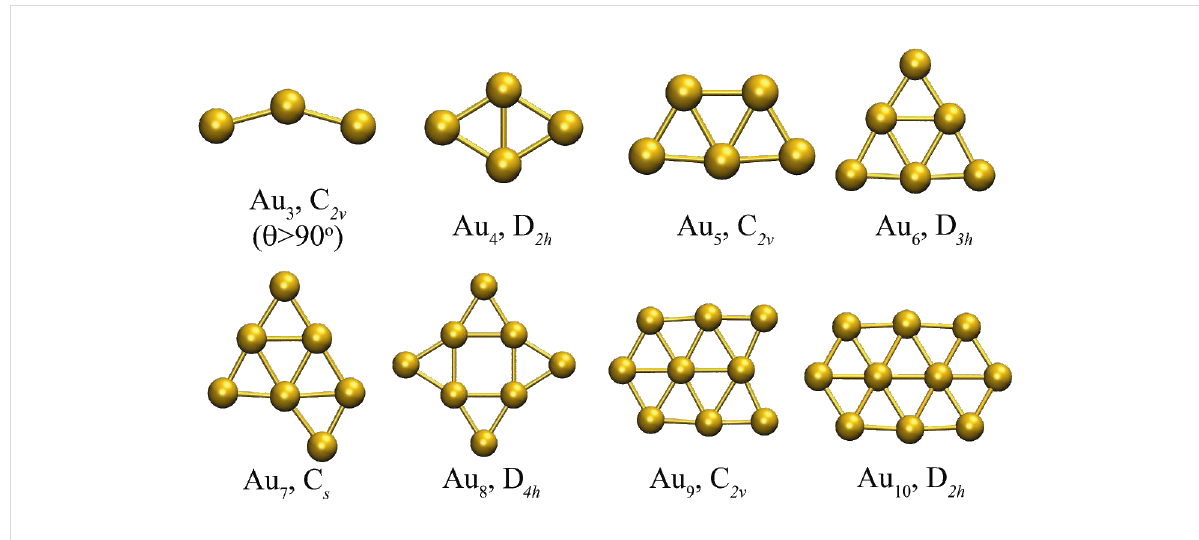
Figure 10: Global minimum energy structures for Au 3 –Au 10 clusters obtained for PBE/VDB, along with their symmetry point group. Structures with equivalent but not identical geometry can be obtained from the empirical potentials by including constraints.